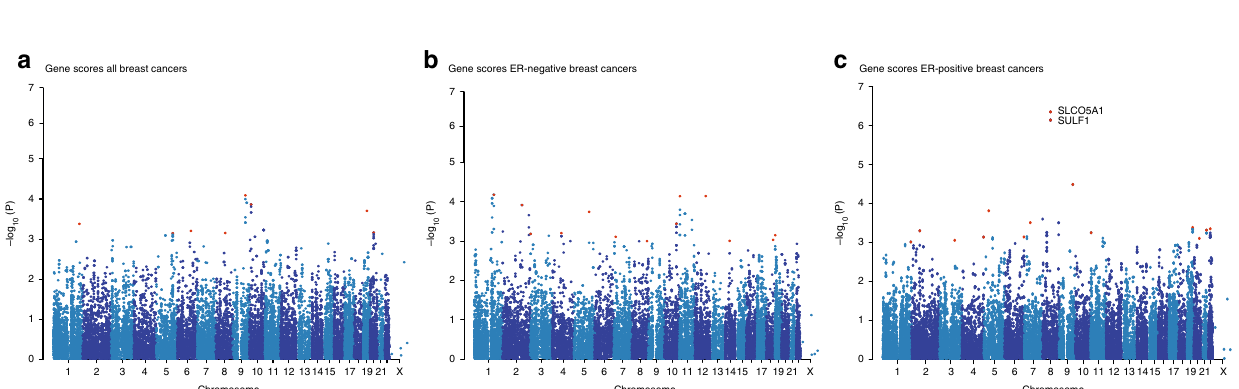
Fig. 2 Manhattan plots of the gene-level associations with breast cancer-speci fi c survival. Plots show the association in a all breast cancer cases ( n = 84,457), b estrogen receptor (ER)-negative ( n = 14,529), and c ER-positive ( n = 55,701). The − log 10 gene P values from the Pascal algorithm is shown on the y axis and genomic position on the x axis. The top signi fi cant genes and the most signi fi cant gene per chromosome (if − log 10 ( P ) > 3) are shown in